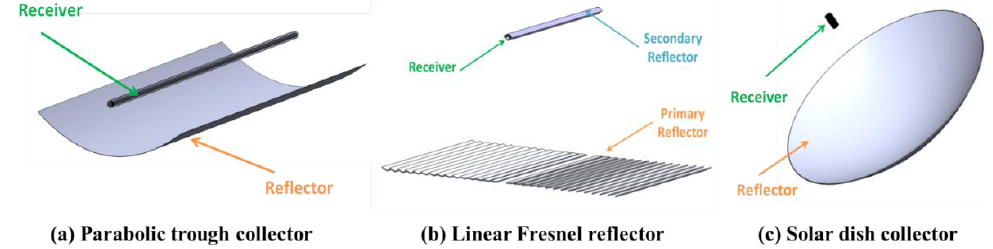
Figure 2. The examined solar concentrating technologies.